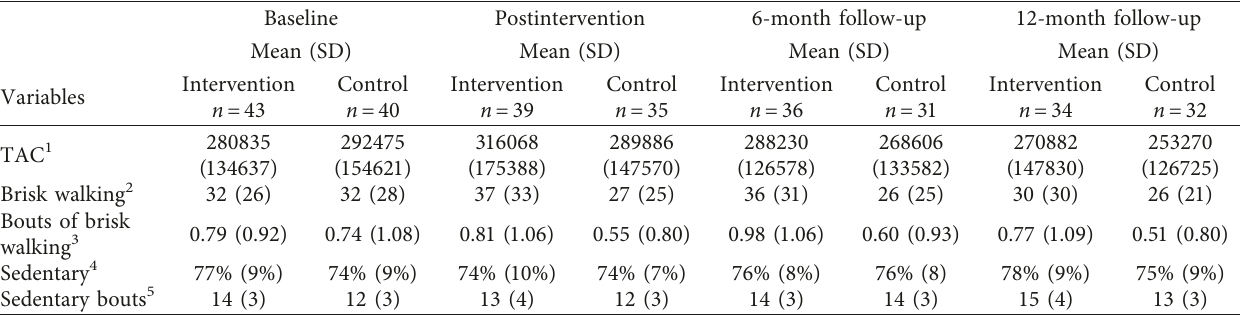
Table 2: Mean values of outcome variables for all four measurement periods for control and intervention groups, respectively. Baseline